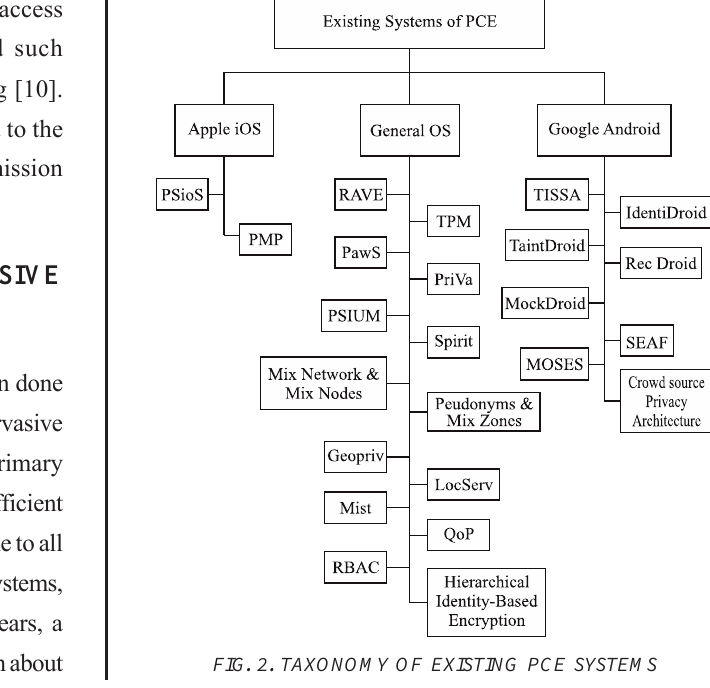
FIG. 2. TAXONOMY OF EXISTING PCE